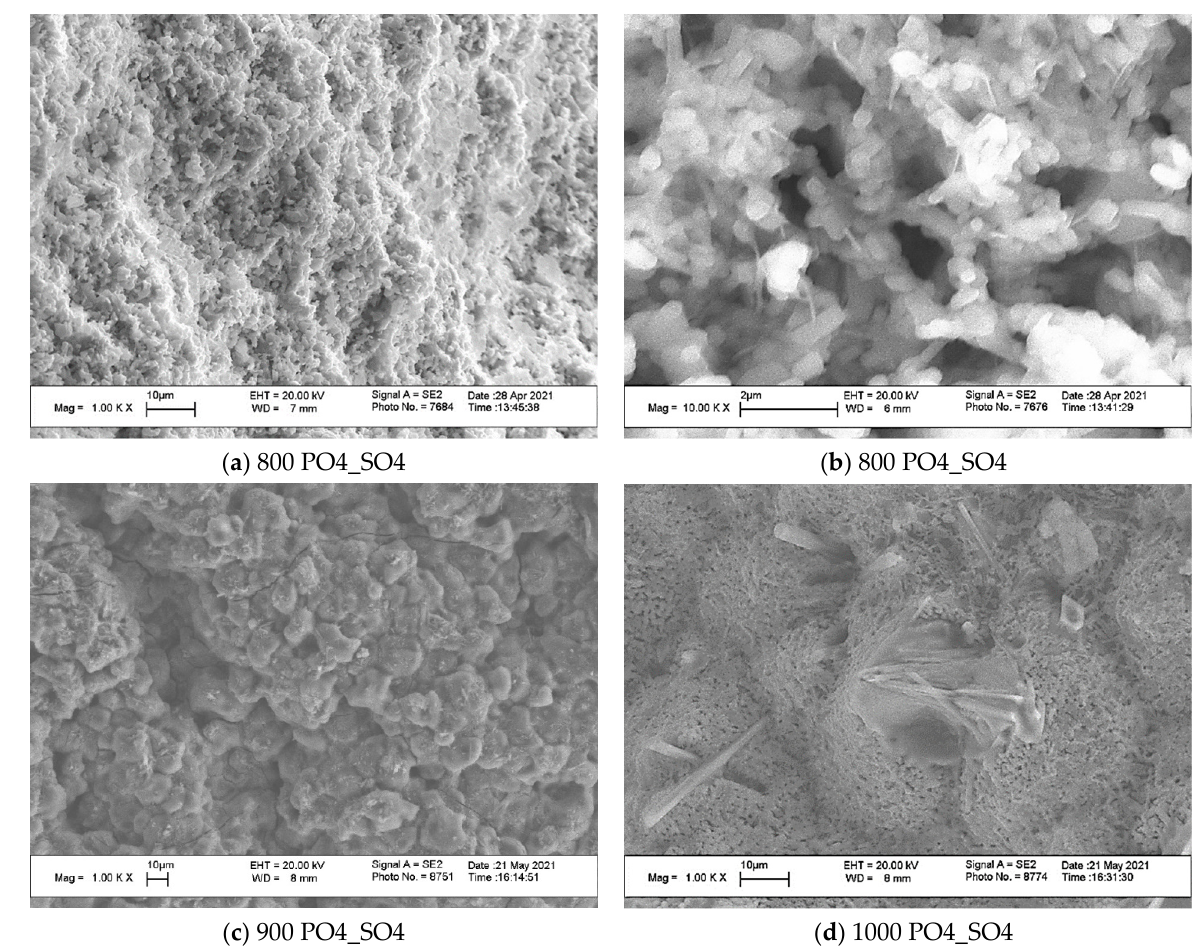
Figure 12. Micrographs of the surface of ceramic samples based on a powder synthesized from calcium chloride CaCl 2 and a mixed-anionic solution of sodium hydrophosphate and sodium sulfate Na 2 HPO 4 /Na 2 SO 4 after firing at 800 ( a , b ), 900 ( c ), 1000 ( d